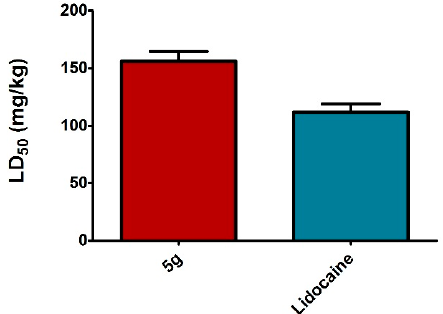
Figure 2. Acute toxicity of (ip) of lidocaine and compound 5g in male mice.